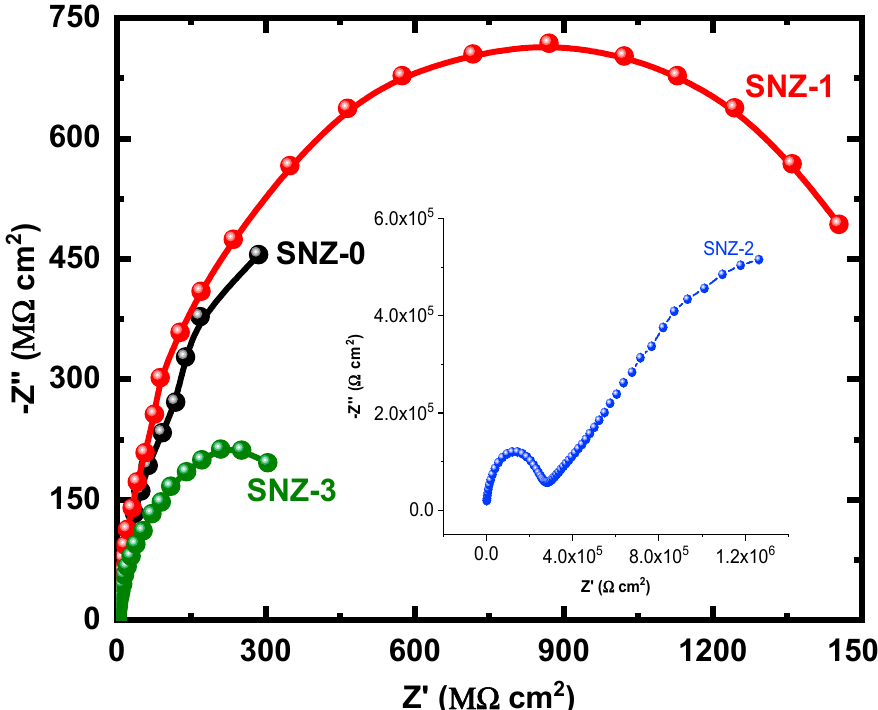
Figure 5. Nyquist plots of the coatings after 5 days’ immersion in a 3.5% NaCl solution.